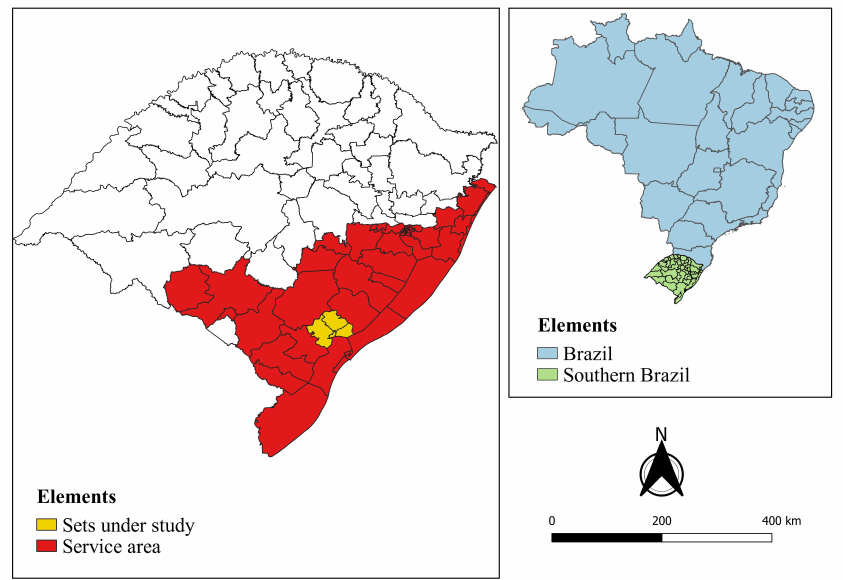
Figure 3. Area served by the distributor under study.